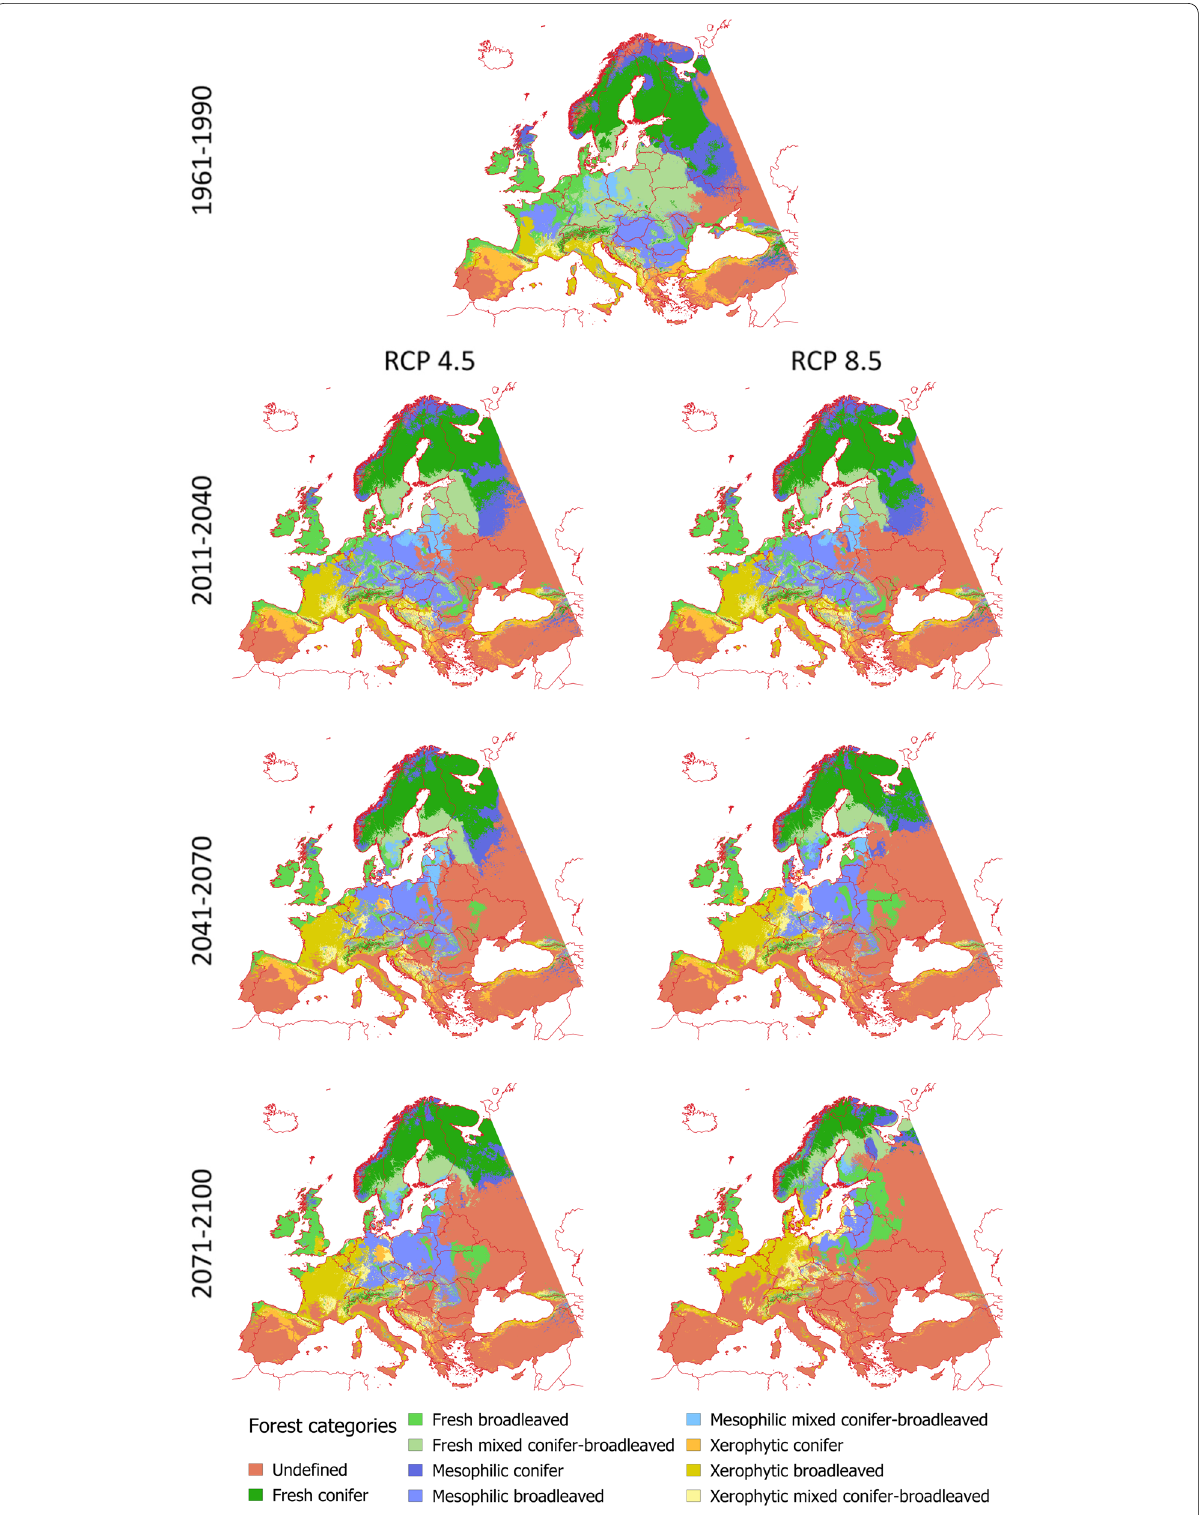
Fig. 5 Maps of tree species-composites for present and future periods according to RCP 4.5 and RCP 8.5 emission scenarios. The species composites are according to Table